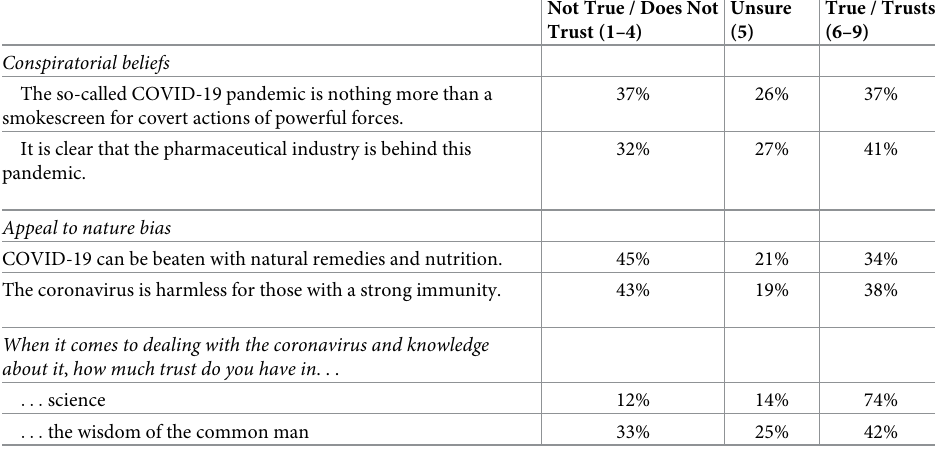
Table 2. Distribution of answers on the endorsement of epistemically suspect beliefs—Study